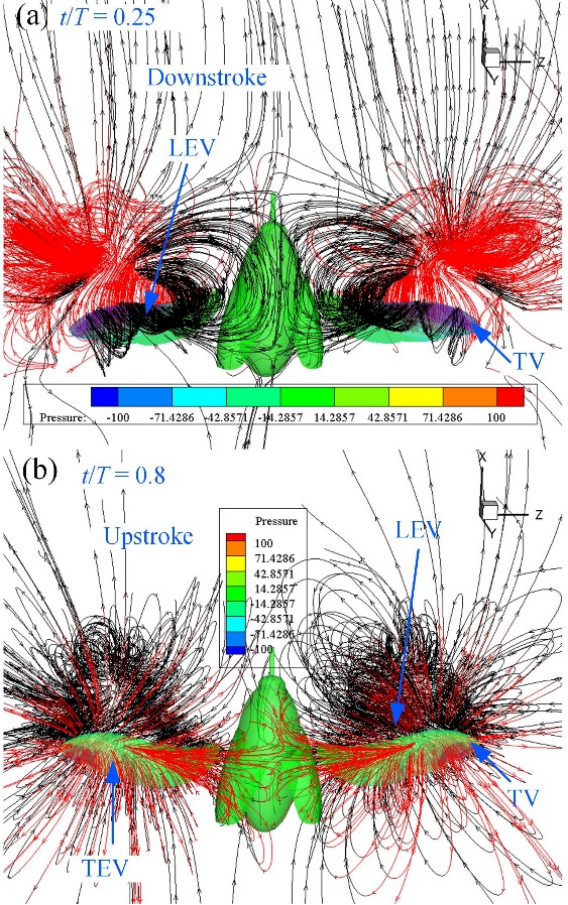
Figure 9. Streamlines around the hindwings at mid-downstroke and near mid-upstroke. ( a ) The LEV and the TV at mid-downstroke. ( b ) The LEV, TEV and the TV at near mid-upstroke.